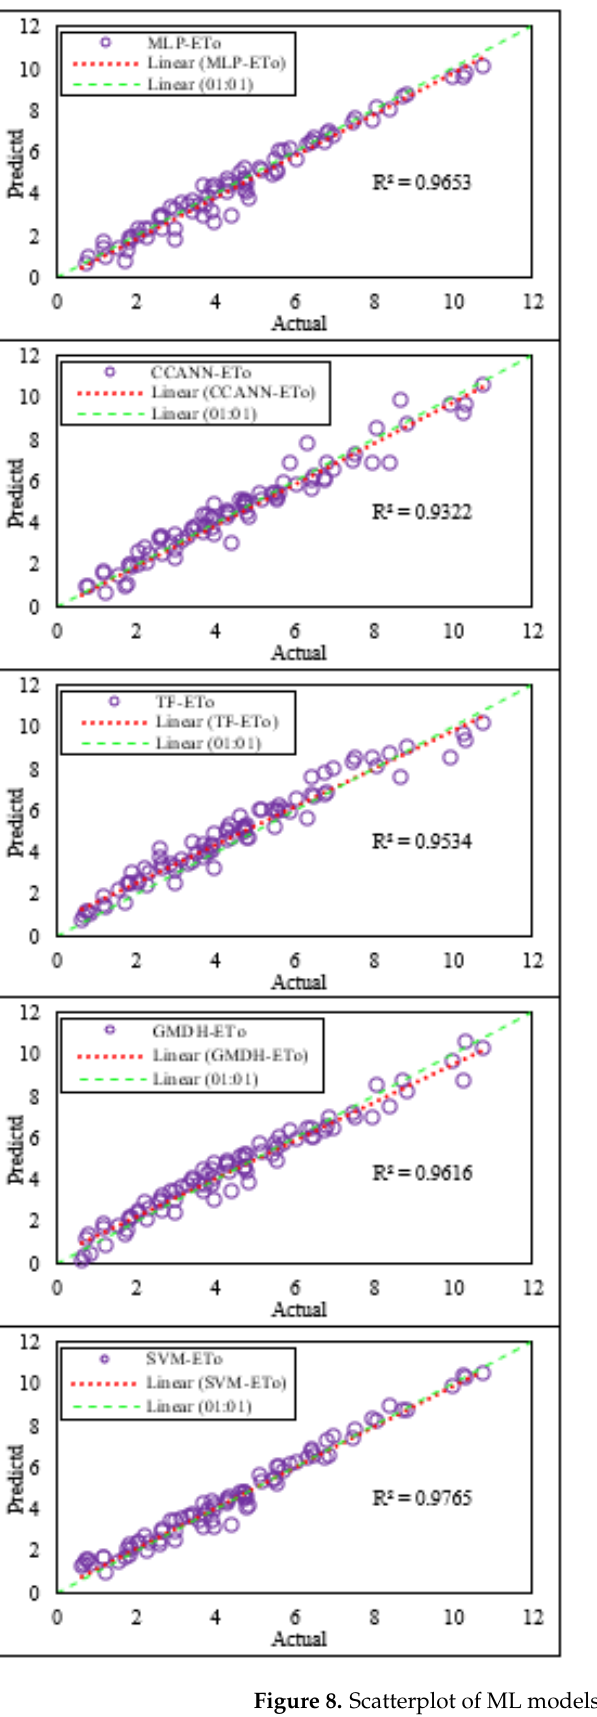
Figure 8. Scatterplot of ML models during the evaluation phase.